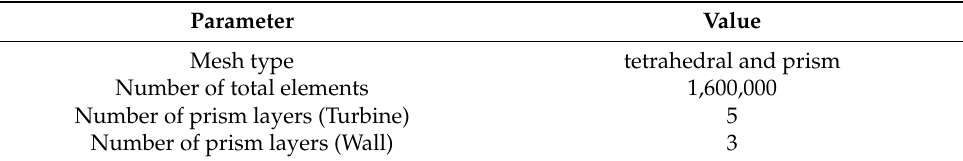
Table 2. Meshing details.